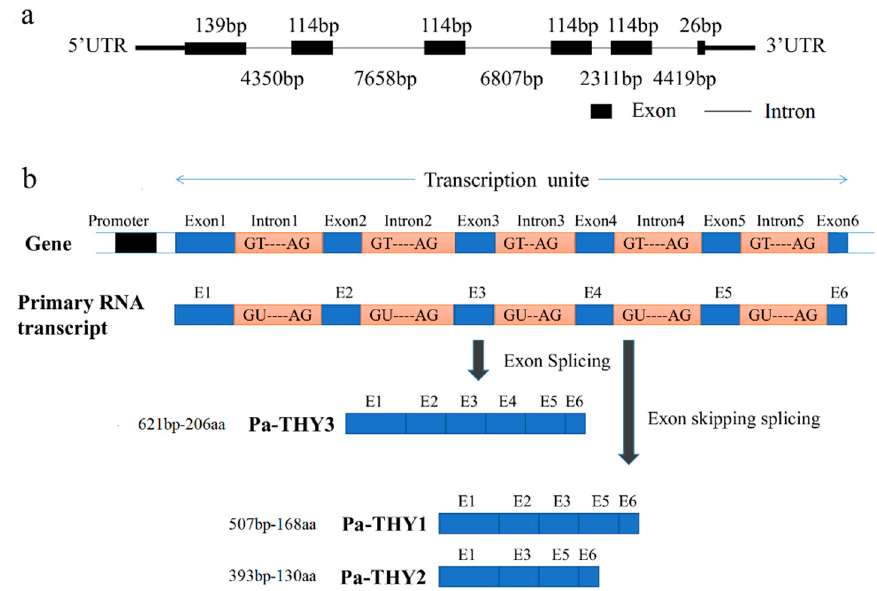
Figure 1. The gene structure of β -thymosin in P. americana . ( a ) The structure and composition of β -thymosin in P. americana . ( b ) The exon skipping splicing process of P. americana thymosin (Pa-THYs).